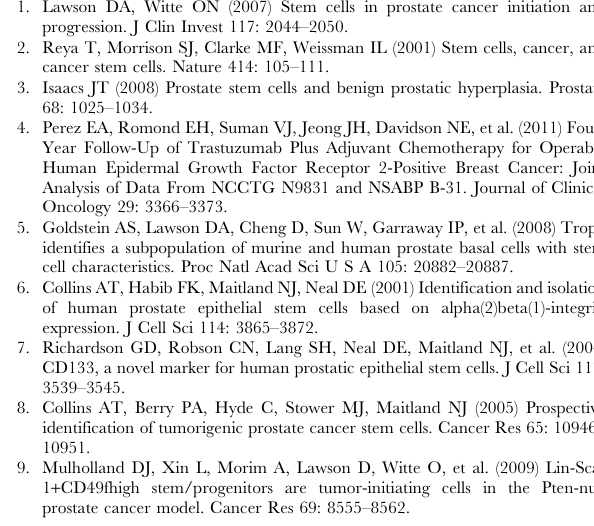
Figure S3 Flow cytometric purity assessment of positive and negative cell fractions following immunomagnetic separation of freshly-isolated human prostate cells using CD49f and CD44 antibodies ( n = 3 patient samples, R1, R3, and R20, see Table S1).